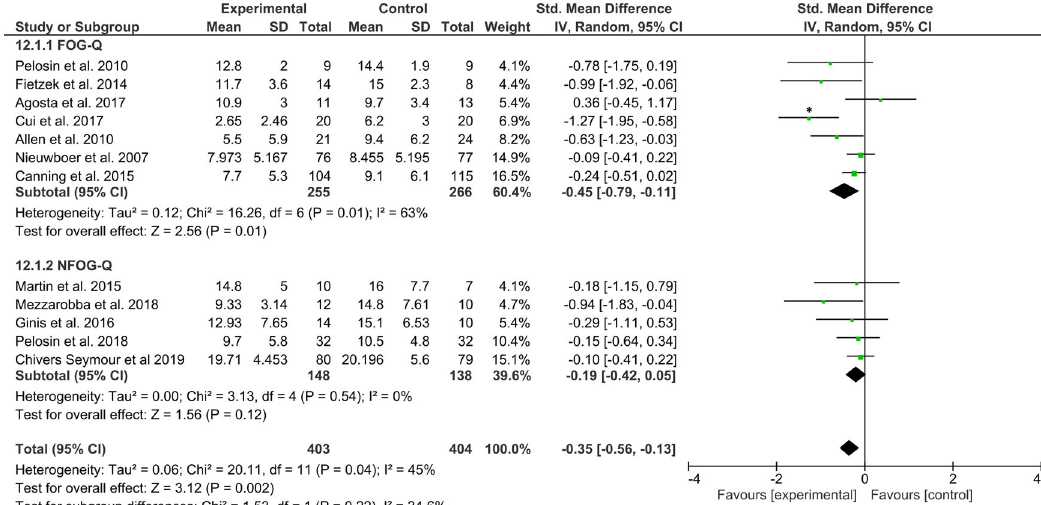
Fig. 7 Secondary analysis comparing effects of category A interventions aimed directly at the alleviation of FOG episodes or FOG- provoking triggers against any type of control group. The studies are arranged per weight of the study as based on sample size; *signi fi cant outliers removed in the sensitivity analysis.